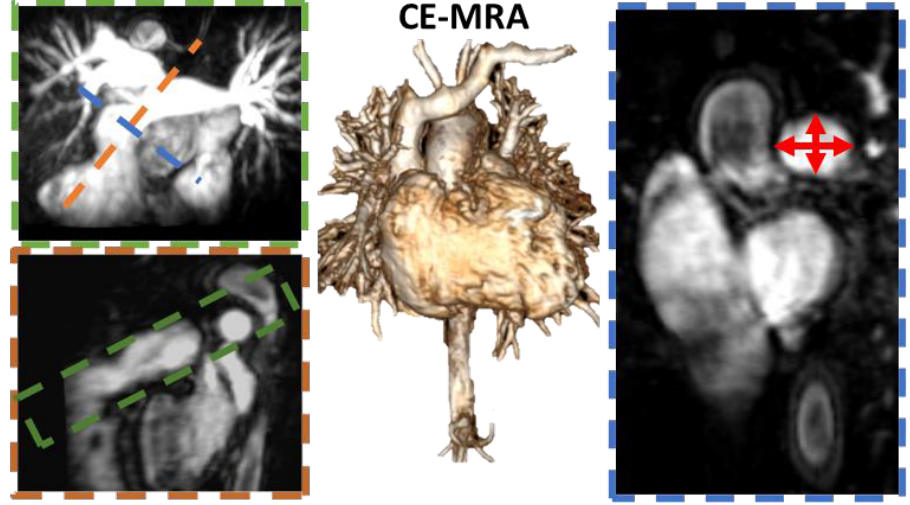
Figure 1. Pulmonary artery diameter measurement. Middle panel shows the contrast-enhanced magnetic resonance angiogram (CE-MRA) used to calculate the pulmonary artery (PA) diameter. For finding the appropriate mild PA location, multi-planar reconstruction (MPR) allowed us to freely navigate the volume, as it showed in the blue, green, and orange planes. An MPR maximum intensity projection was used for the green plane to accurately project the PA volume. Red arrows show samples of diameter measurements.